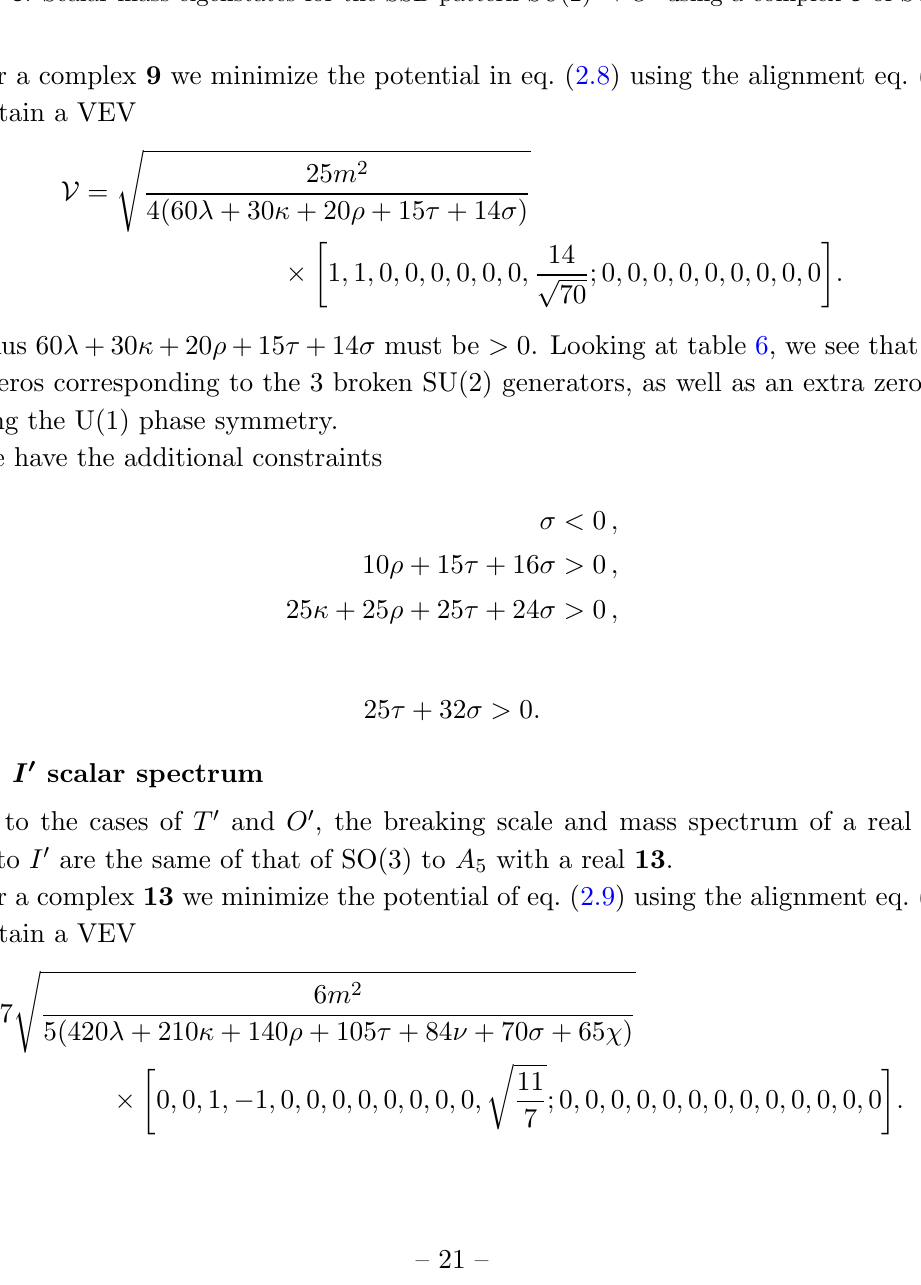
Table 6 . Scalar mass eigenstates for the SSB pattern SU(2) ! O 0 using a complex 9 of